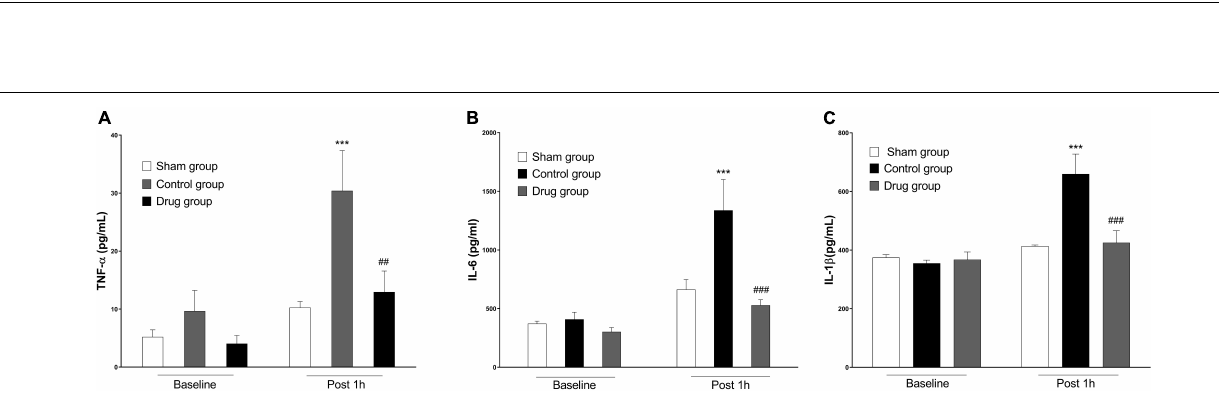
FIGURE 2 | MP effects on post-resuscitation pro-inflammatory cytokines. (A) Plasma levels of TNF- α , (B) plasma levels of IL-6, (C) plasma levels of IL-1 β . TNF- α , tumor necrosis factor- α ; IL-6, interleukin 6; IL-1 β , interleukin 1 β . Data are presented as mean ± SD. *** p < 0.001 control vs. sham group; ## p < 0.01, ### p < 0.001, drug vs. control